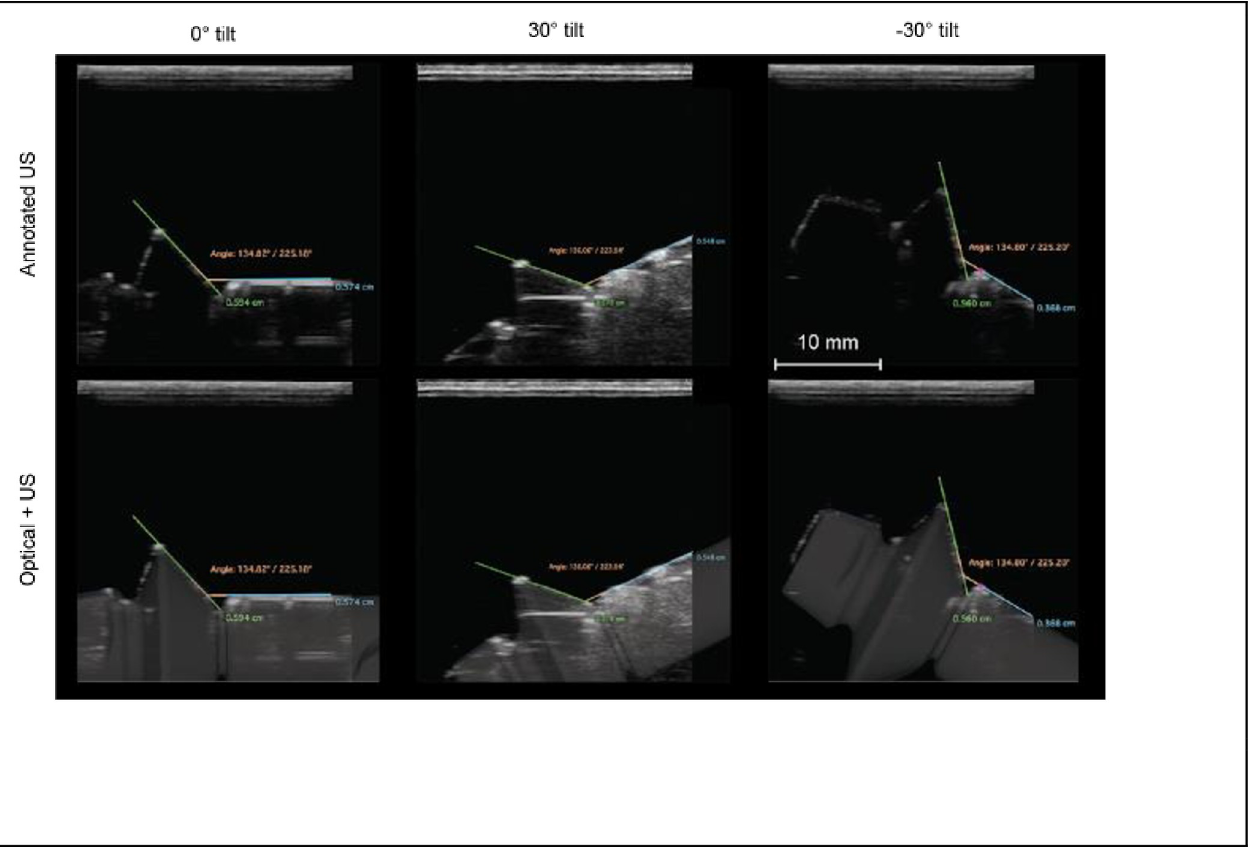
Fig 3. Top row: Measurement of the abutment angle on abutment 9–3. Columns left, middle and right, are labeled with the degree angle between the abutment and the ultrasound transducer, i.e., 0˚, +30˚, and -30˚ with respective abutment-holder angle measurements of 134.8˚, 136.1˚, and 134.8˚. Bottom row: Overlay images for the respective optical (reference) and ultrasonic scans. (Scale bar for all images).